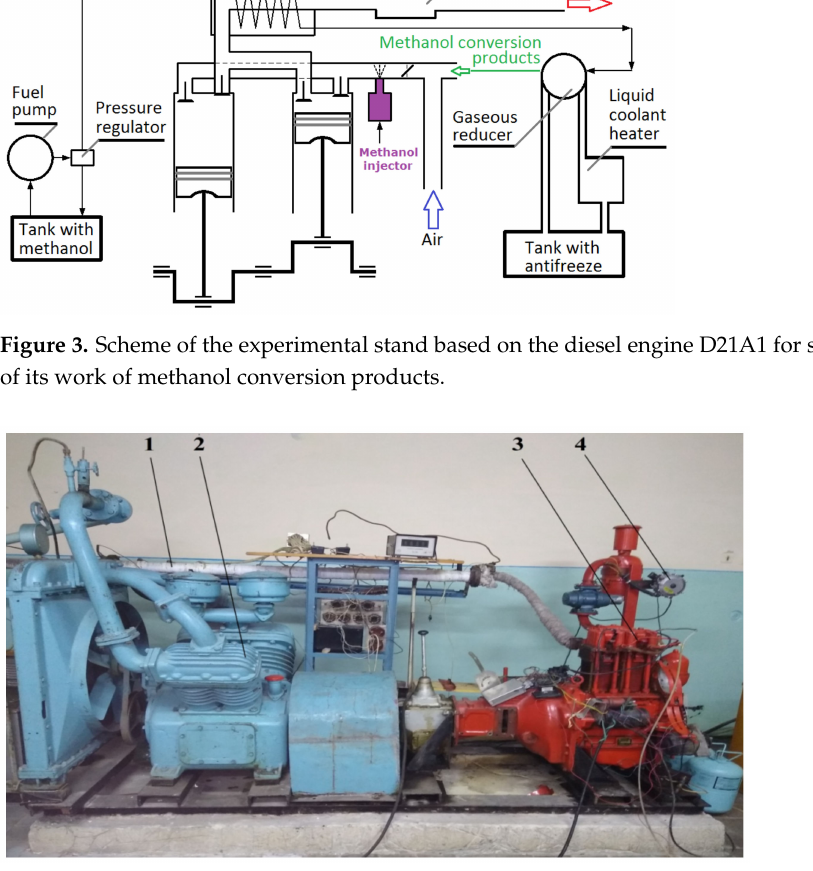
Figure 4. Appearance of the experimental stand based on the diesel engine D21A1 for the study of parameters on alternative fuel mixtures. 1—thermochemical reactor; 2—loading device of the internal combustion engine; 3—D21A1 diesel engine; 4—gas